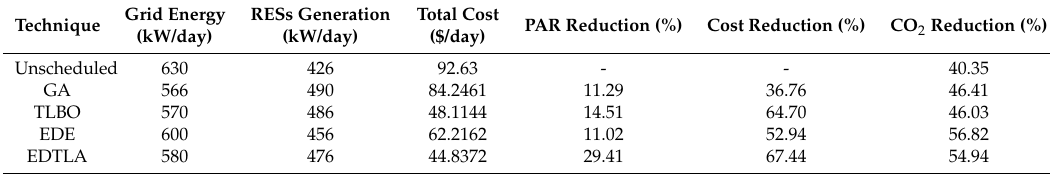
Figure 19. PAR with RESs integration. Table 4. Summarized results with RESs and battery storage system